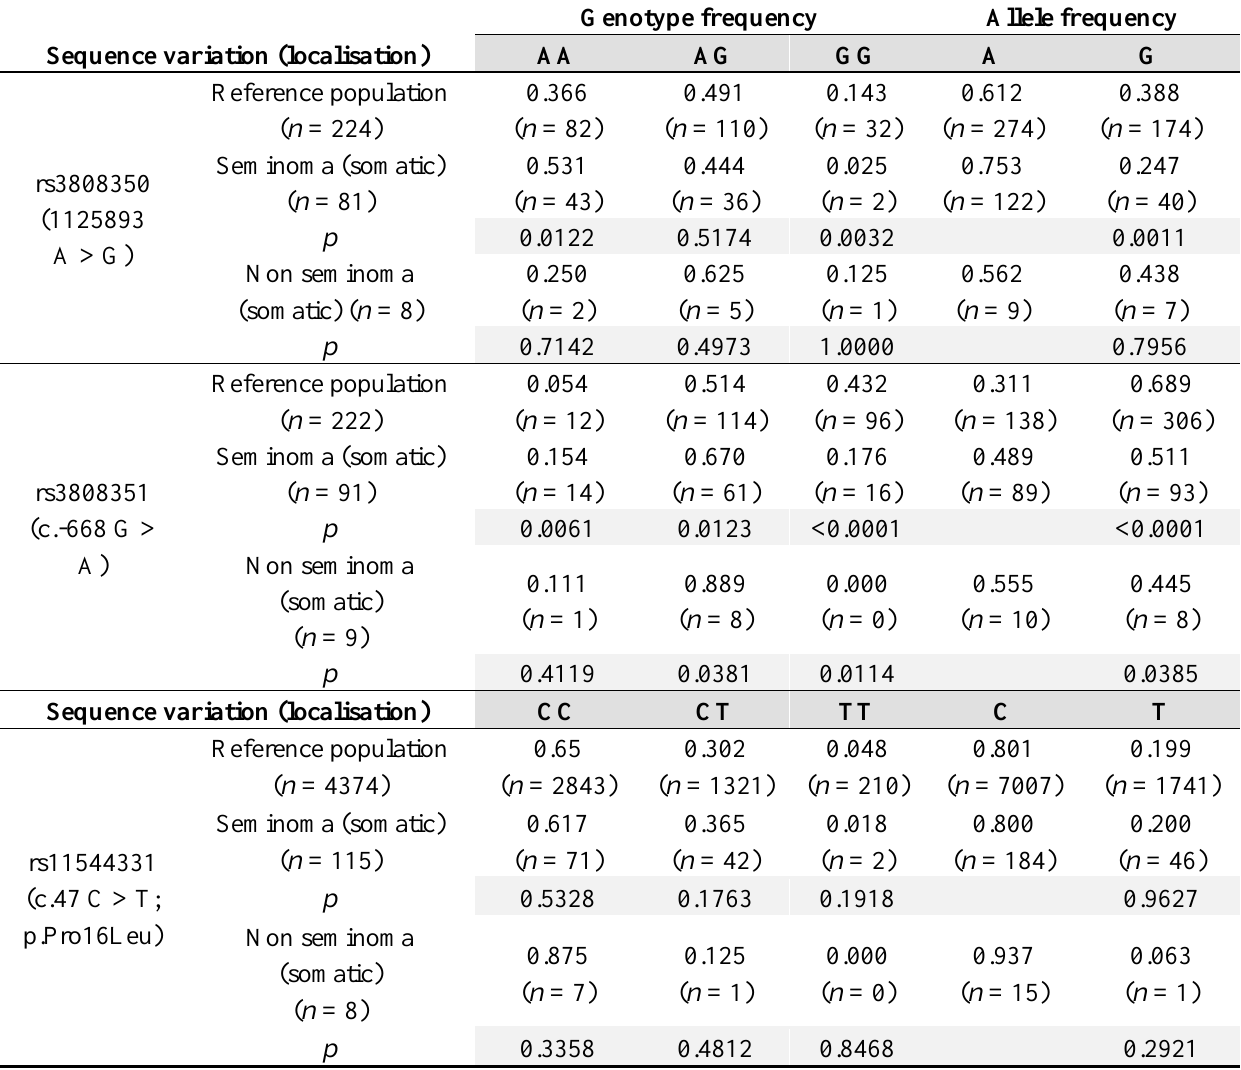
Table 1. Analysis of GPER single nucleotide polymorphisms (SNP) frequencies in seminoma and non-seminomas tissues. Allele and genotype frequencies were determined after performing tests for deviation from the Hardy-Weinberg equilibrium. “ n ” is the total number of samples in each